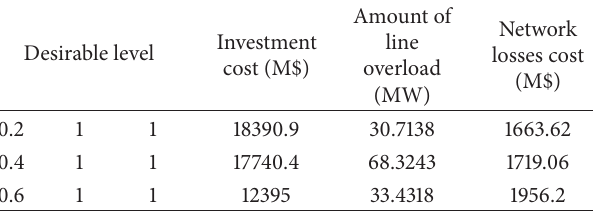
Table 4: Final planning scheme of the real test